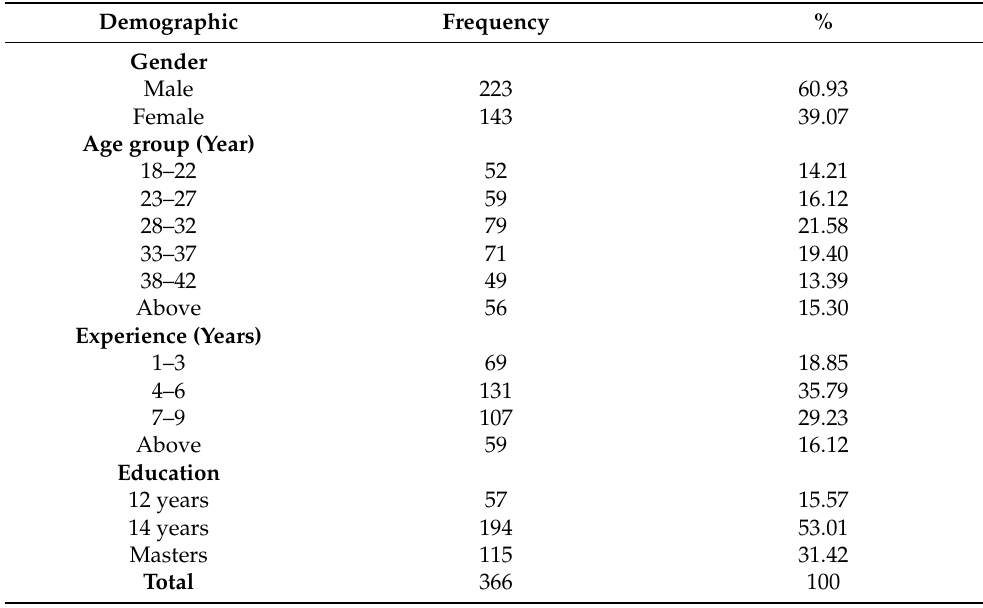
Table 1. Demographic detail of